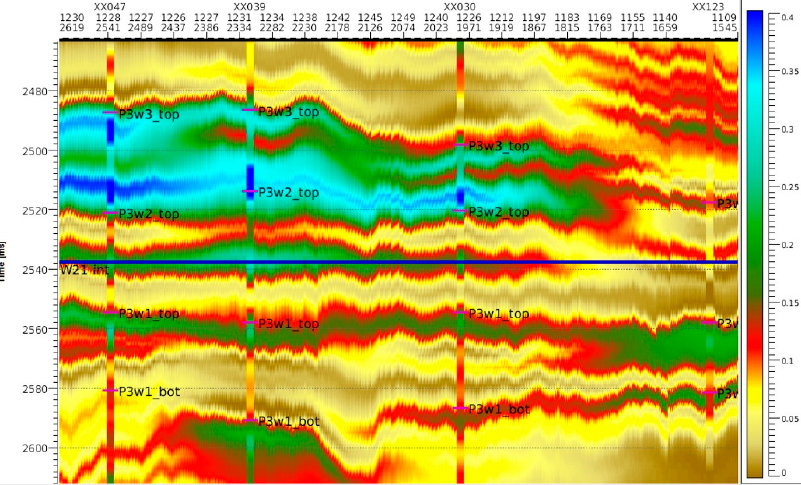
Figure 2. The distribution of the clay content obtained from conventional logging interpretations.